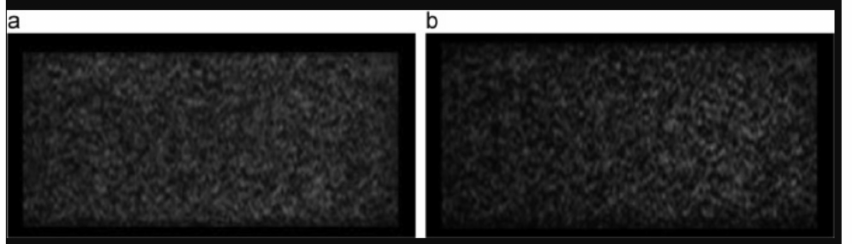
Figure 14. Nuclear magnetic resonance images of core 94-2 from the clay-enriched Nanyang sandstone reservoir: ( a ) pH = 7.0; ( b ) pH = 13.0